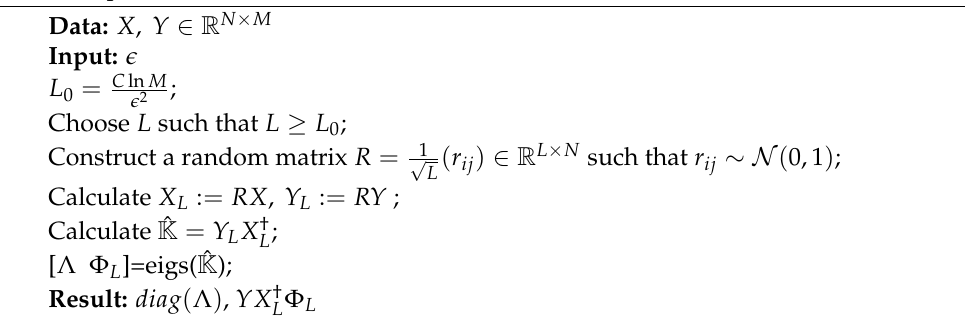
Algorithm 1 Randomized DMD (rDMD). Figure 4 shows the details of the input and output